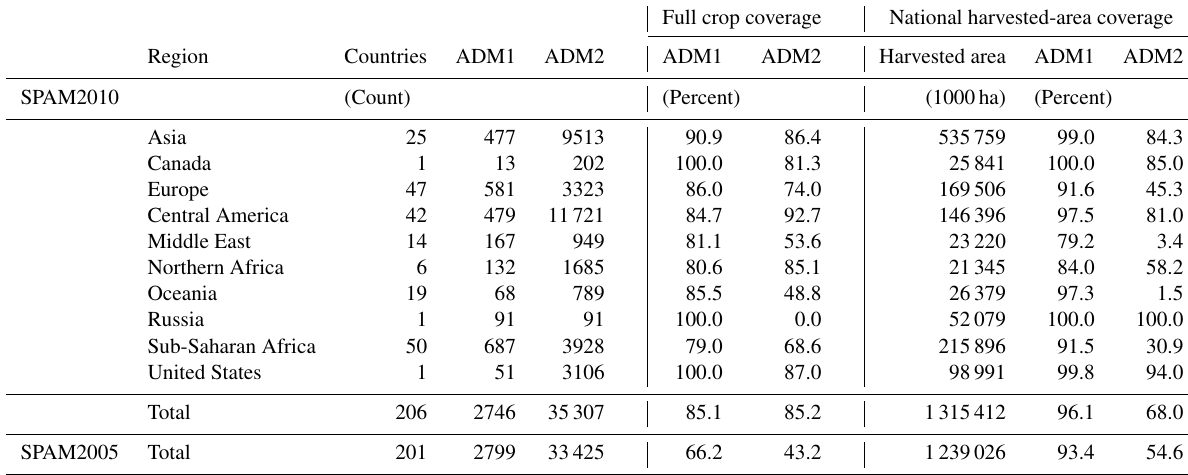
Table 1. Subnational coverage of crop production statistics by